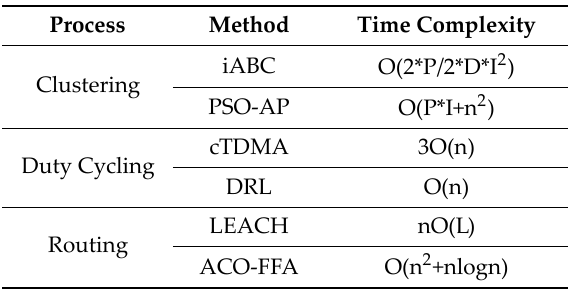
Table 3. Time complexity